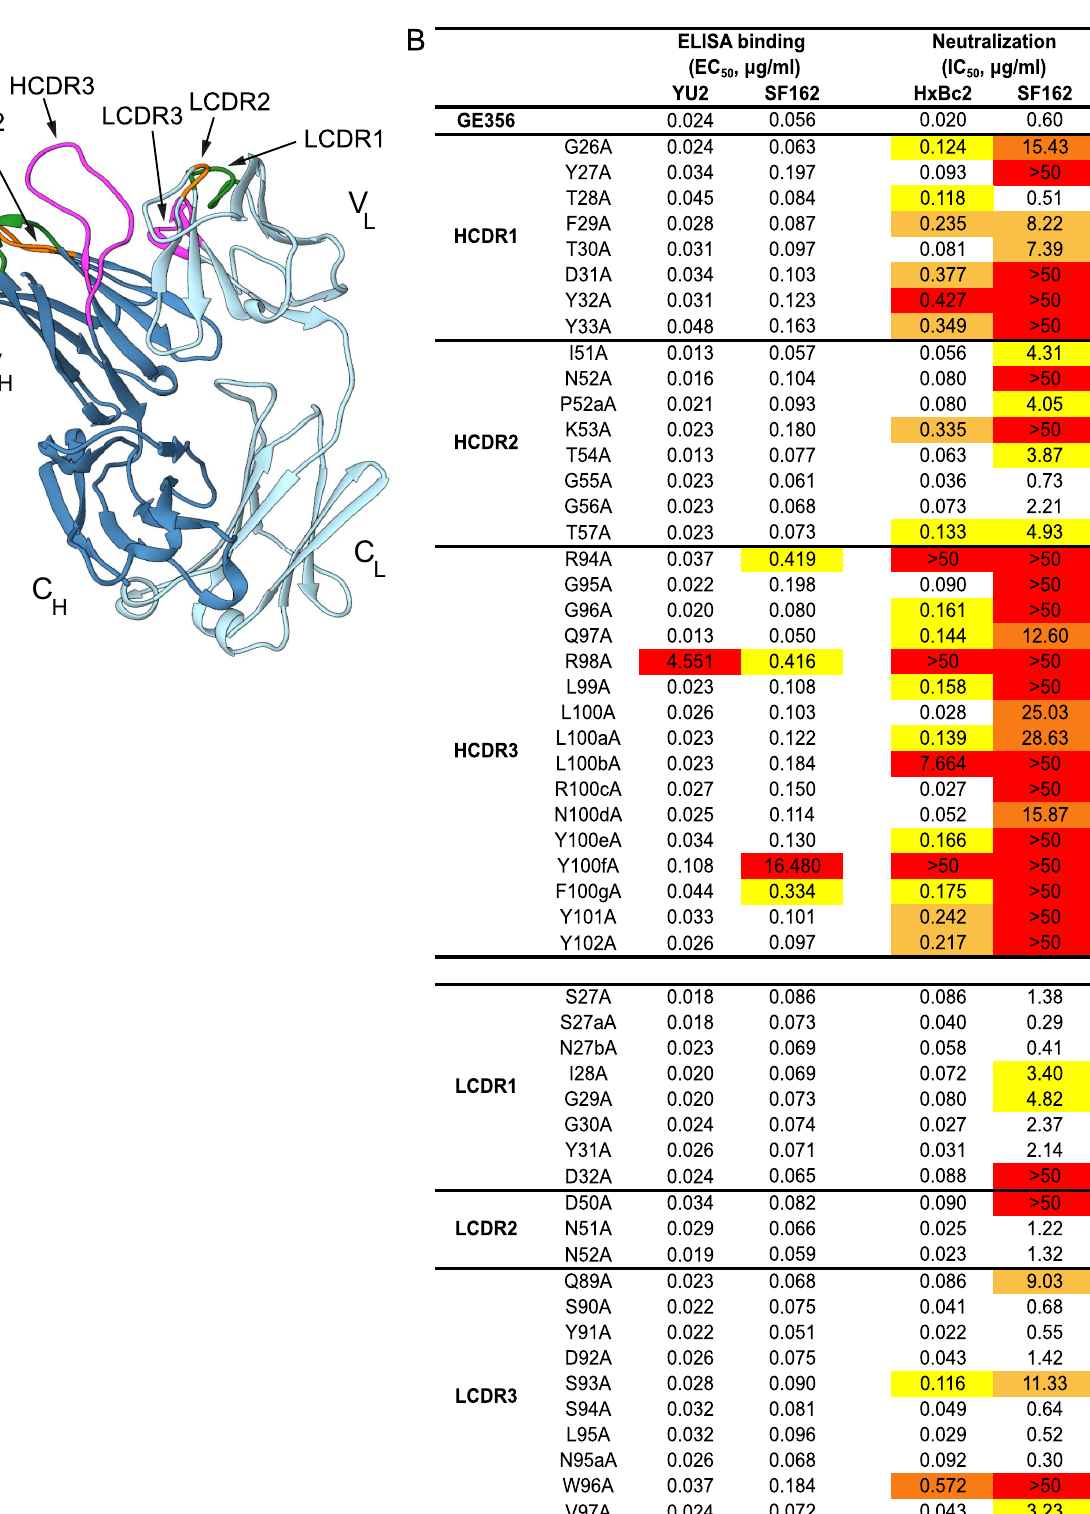
Figure 5. Representation of the GE356 Fab crystal structure and paratope mapping analysis. (A) The GE356 heavy chain is shown in dark blue and light chain in light blue. The HCDR and LCDR loops are colored as follows: CDR1s (green), CDR2s (orange), CDR3s (magenta). (B) Effects of alanine substitutions in the CDRs of the heavy and light chain of GE356 on YU2 and SF162 gp120 binding (left) by ELISA and neutralization capacity (HXBc2 and SF162, right), as measured using the TZM-bl pseudovirus assay, compared to WT GE356. Residues are numbered based on the Kabat numbering system. EC 50 (Ab concentration for half-maximal binding) and IC 50 (Ab concentration for 50% neutralization) values are shown. The color-